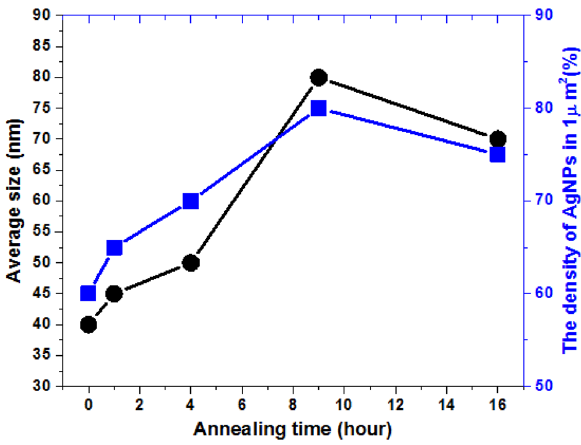
Figure 4. Average size and the density of AgNPs (in 1 μm 2 ) as a function of annealing time (hour).